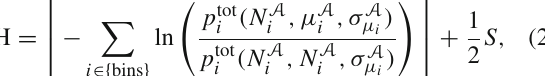
( E reco ) and ν 10